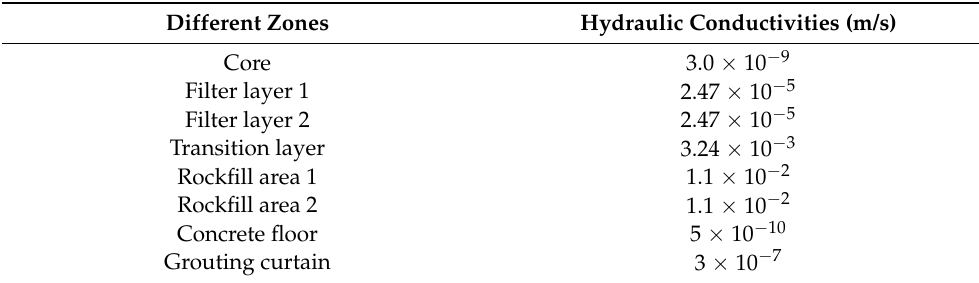
Table 4. Hydraulic conductivities of different zones of the dam body.